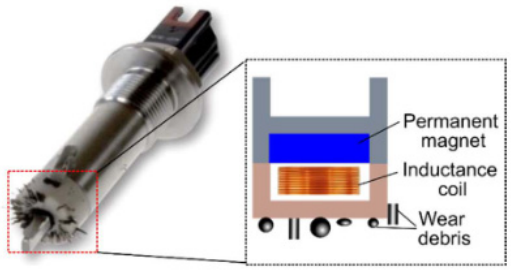
Figure 3. Schematic of ferrous particle sensor developed by Gill sensors [21].